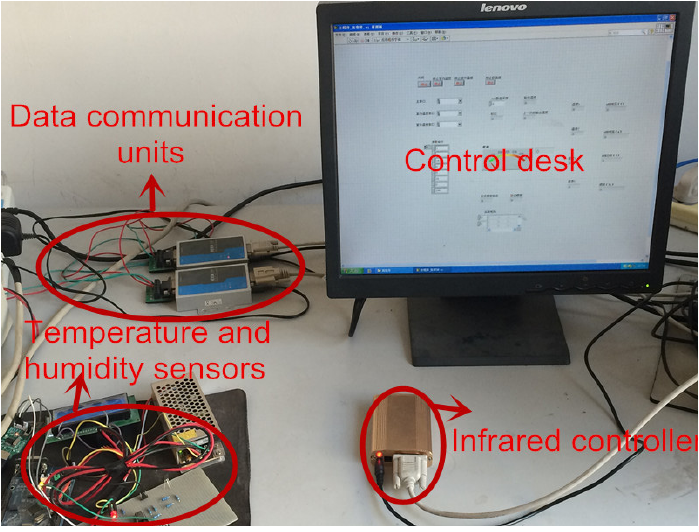
Figure 7. Measurement, communication and control modules.